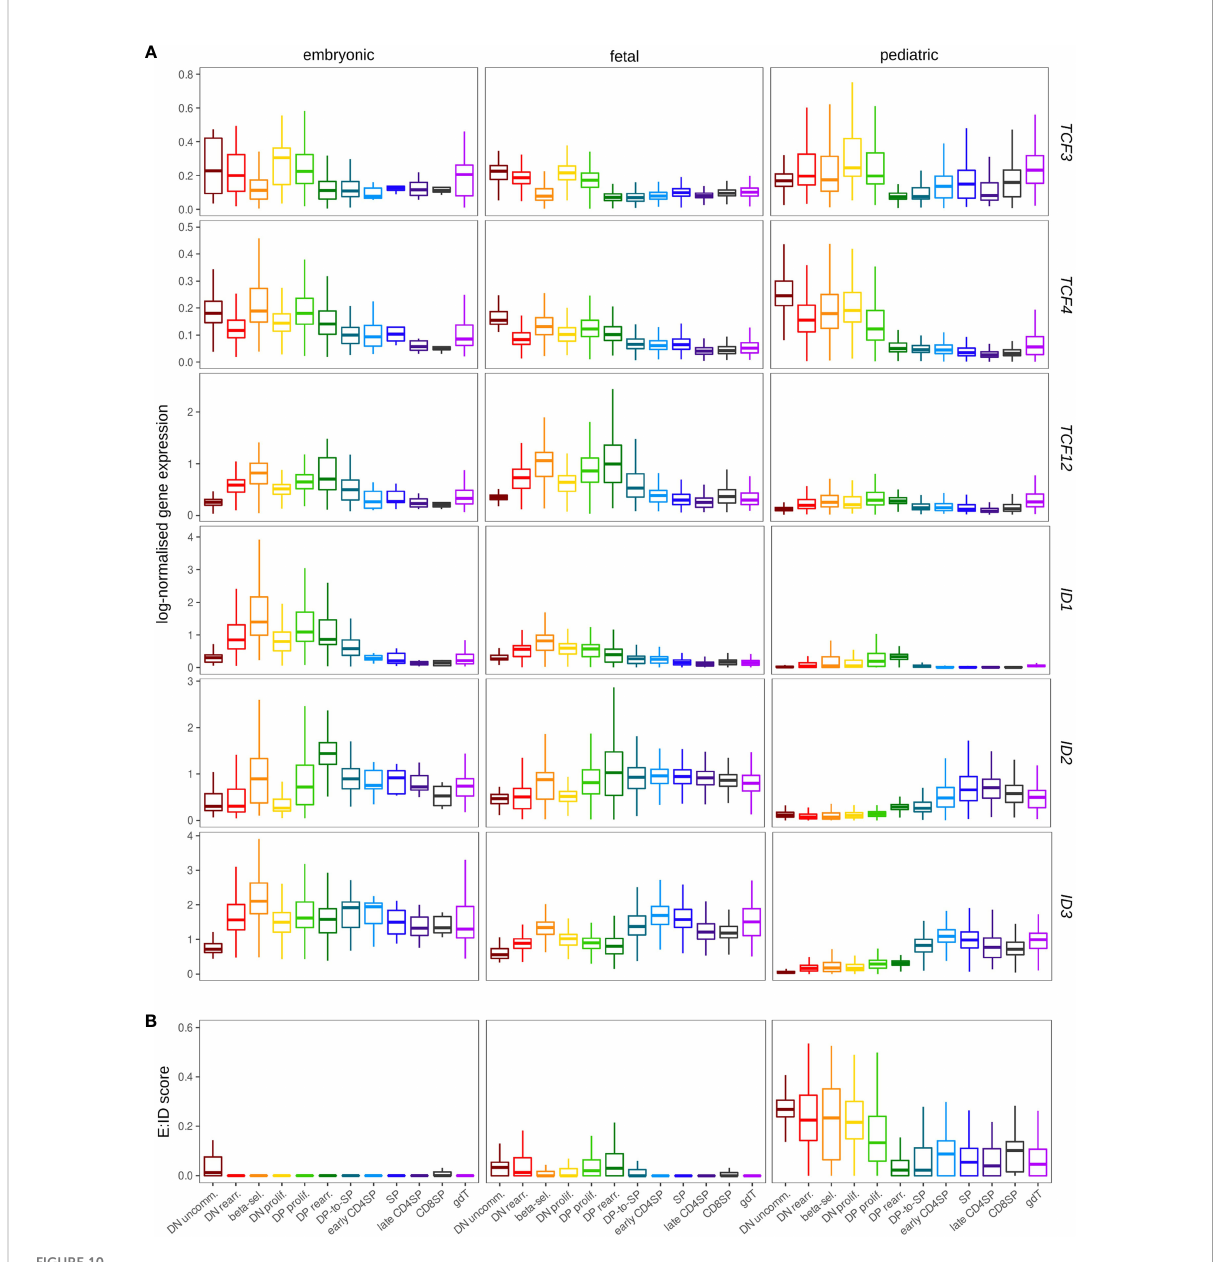
FIGURE 10 Expression of ID protein encoding genes exhibits different patterns in the pre- and postnatal thymocytes. (A) Pseudo-bulk expression of E and ID protein encoding genes in thymocytes based on prenatal and pediatric single cell data sets. The prenatal data was divided into embryonic ( ≤ 10 wpc) and fetal (>10 wpc) samples. Note that only very few SP, early/late CD4 + and CD8 + SP thymocytes were detected in embryonic samples (see Figure S7C). (B) Average E:ID score per cell type in embryonic, fetal, and pediatric